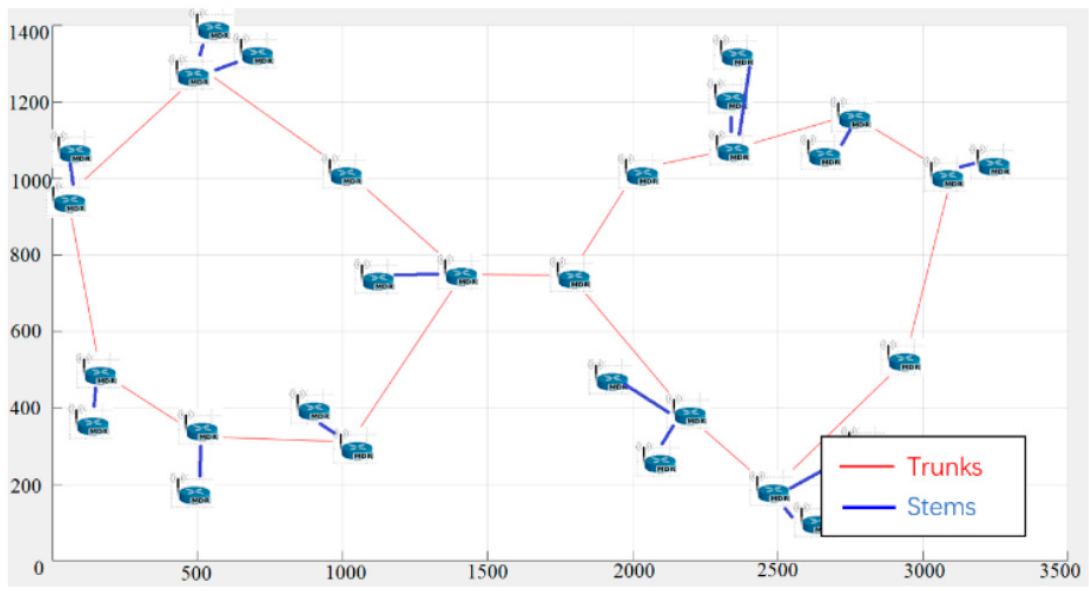
Figure 2. An example network topology with skeleton